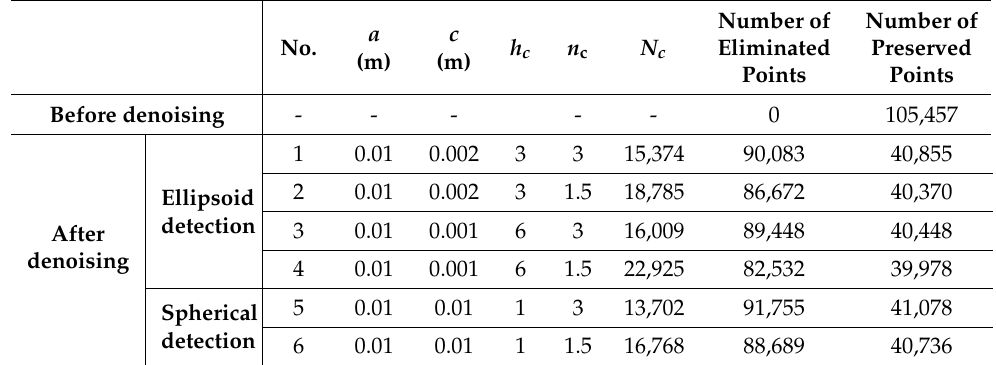
Table 4. The denoising results of the concrete pavement point cloud with stone and kerb noise points by different denoising parameters.